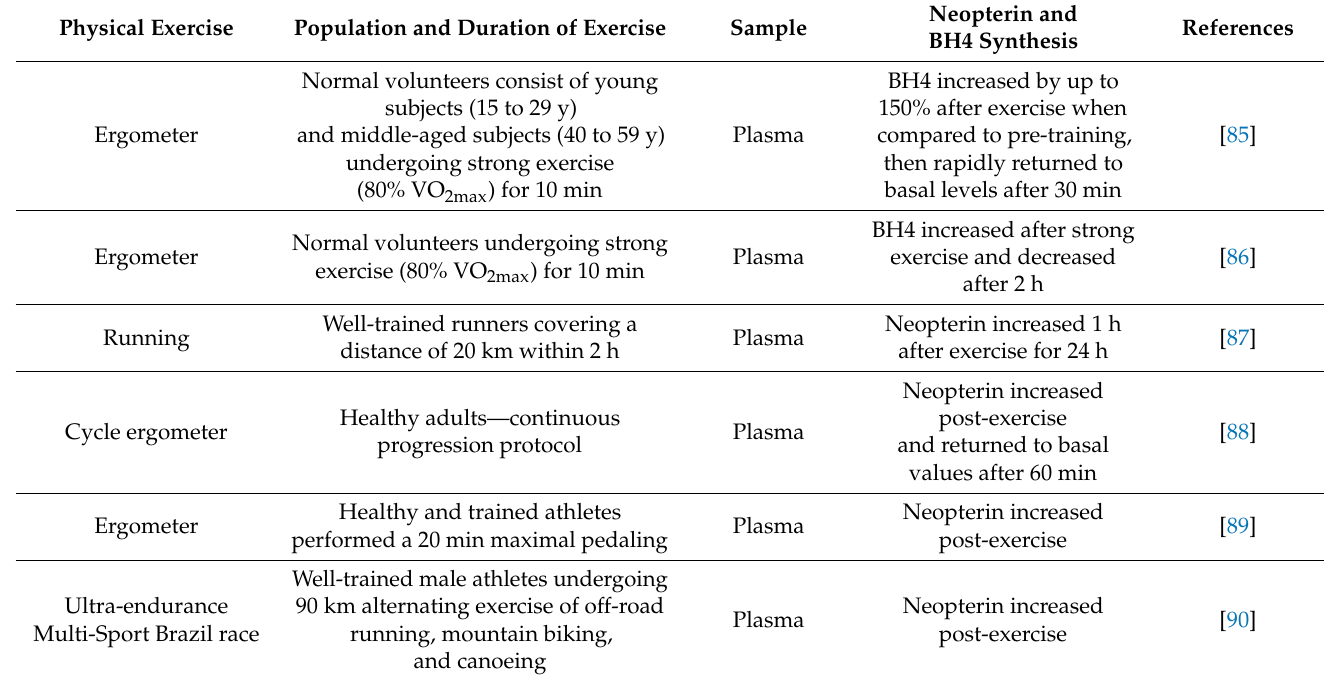
Table 2. Activation of the synthesis of tetrahydrobiopterin (BH4) induced by